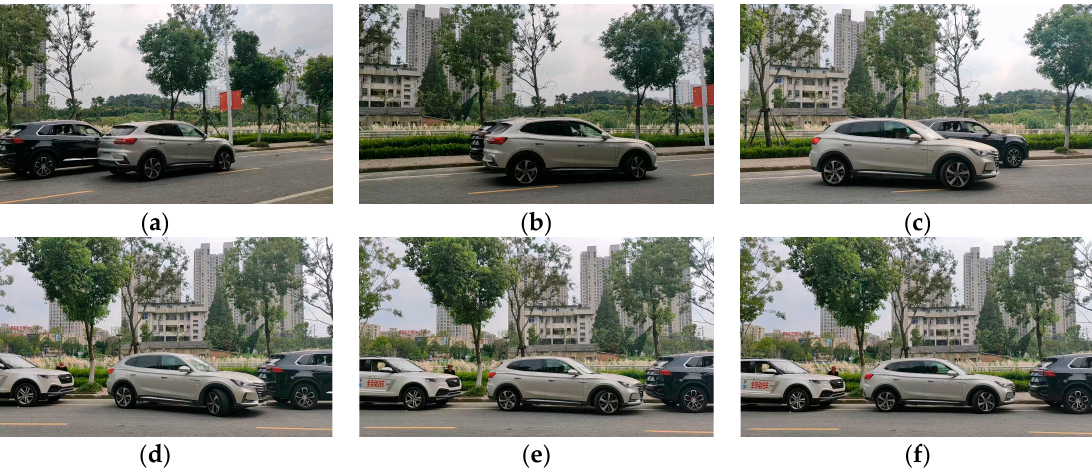
Figure 17. Parallel parking trajectory comparison experiment: ( a ) Start parking; ( b ) Car turning; ( c ) Continuous turning; ( d ) Second turning; ( e ) Enter the parking space; ( f ) Complete parking.